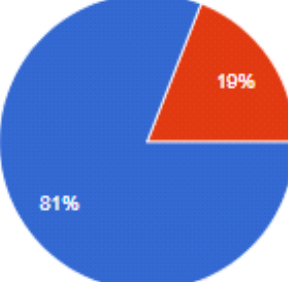
Figure 14. Energy storage.